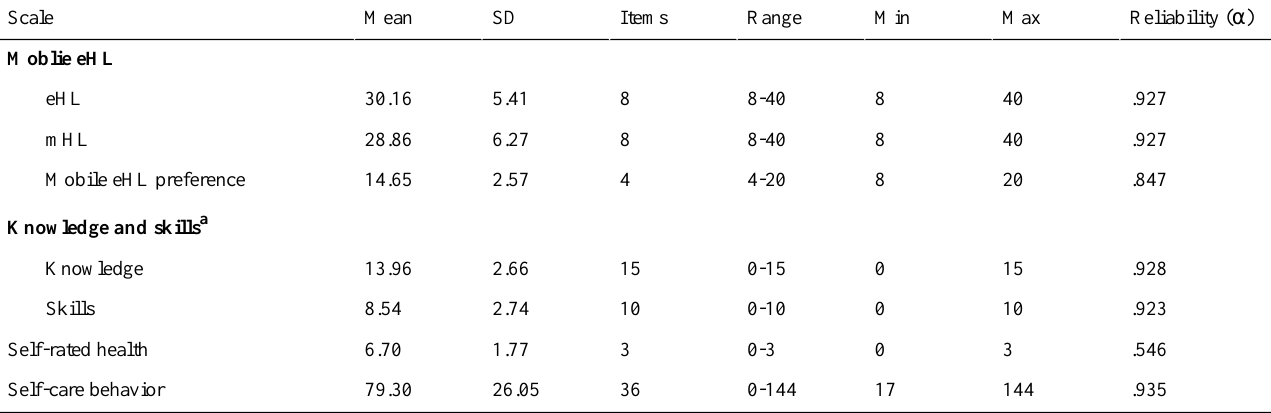
Table 3. Means, standard deviations, and Cronbach alpha values for self-rated health, self-care behavior, eHealth literacy (eHL), mobile health literacy (mHL), mobile eHL preference, and knowledge and skills of computers, internet, and mobile technology